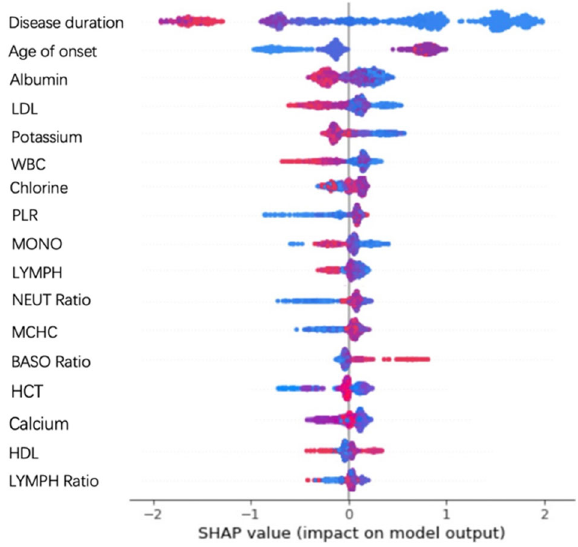
Fig. 5 Dot plot of feature importance. Dot plot of feature importance calculated using the mean SHAP values from running 10-fold cross validation on the training set for 1000 times. The x-axis was the SHAP value (in unit of log odds) of the features used for diagnosis classi fi cation. Each row shows the importance of different values of one feature, with red color indicating high feature values and blue color indicating low feature values. The positive x-axis represents the importance of each feature value to support unipolar depression, and the negative axis represents the importance of each feature value to support bipolar depression. The rows were ranked by the overall feature importance vertically. Therefore, disease duration has the strongest drive to the model ’ s prediction, while LYMPH ratio has a relatively weaker drive. Notably, when points do not fi t together on the line, they pile up vertically to show density. Table 2. Comparison of each blood biomarker of unipolar and bipolar depression between the two